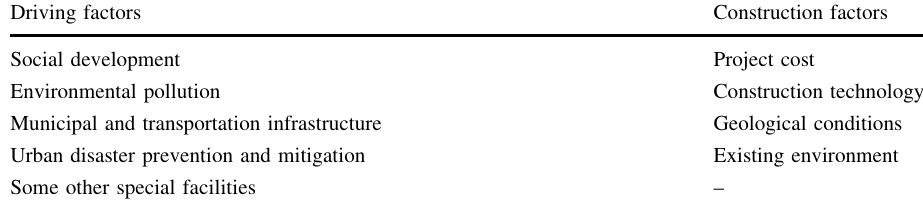
Table 1 Affecting factors of the demand forecasting of underground space